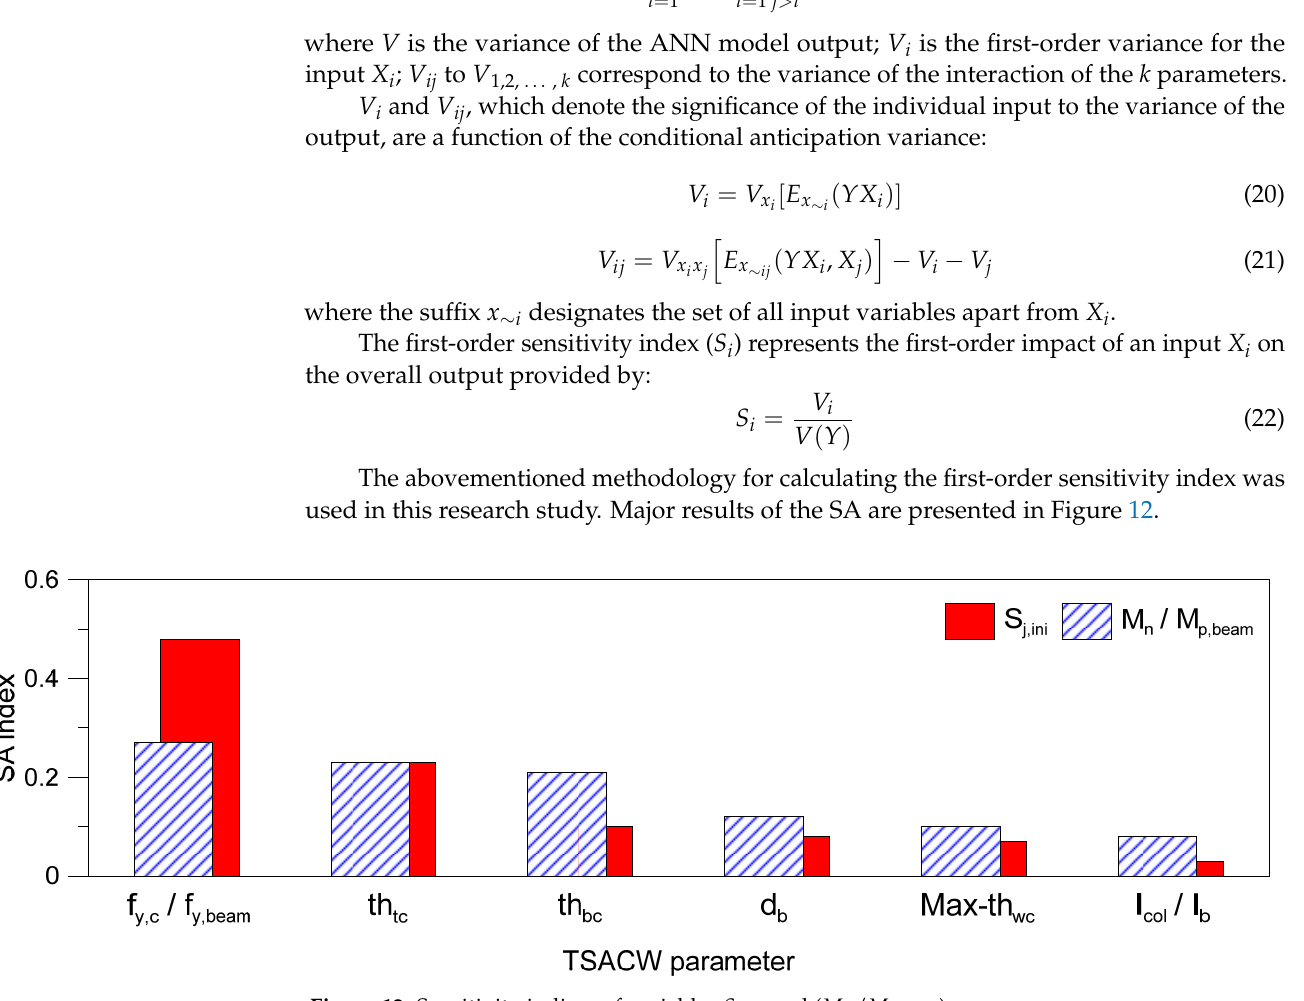
Figure 12. Sensitivity indices of variables S j,ini and ( M n / M p,beam ).